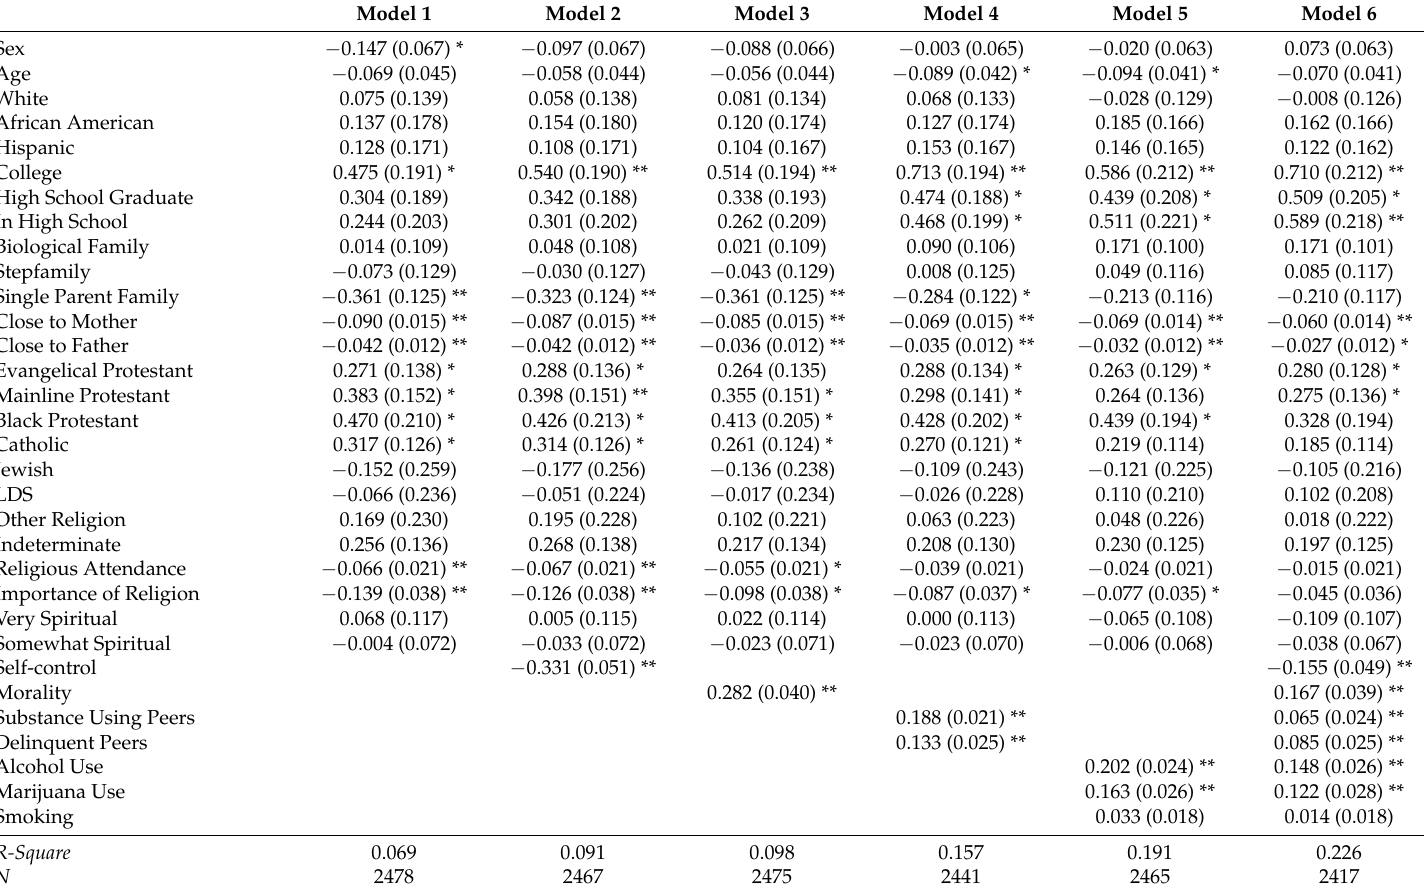
Table 4. OLS Regression of Keeping Secrets from Parents on Religion and Mediators (Standard